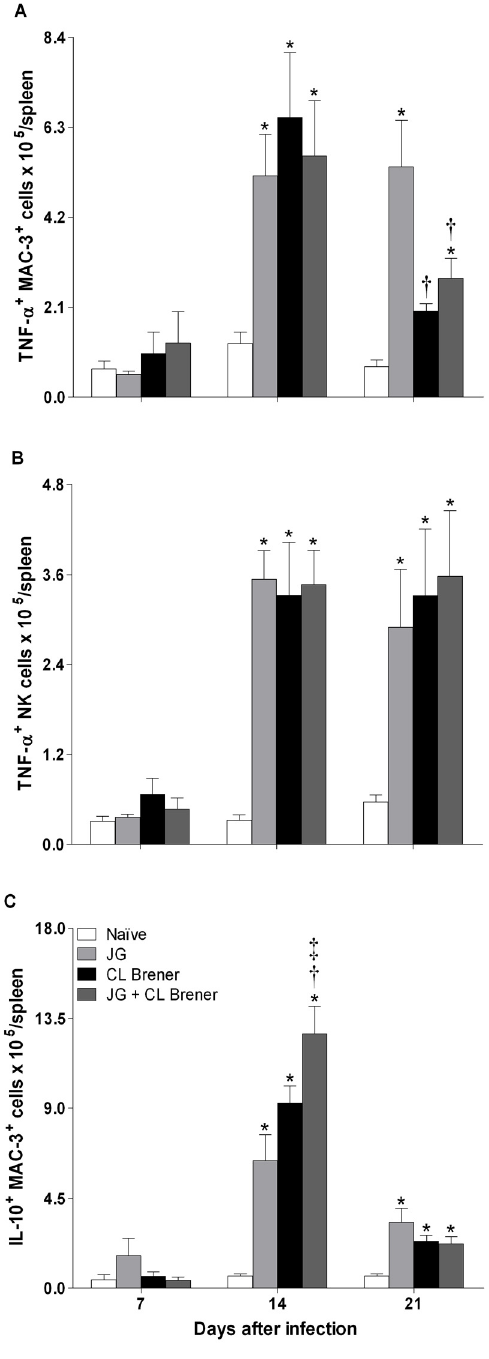
Figure 7. Flow cytometry analysis of splenic MAC-3 + and NK cells from BALB/c mice infected with JG and/or CL Brener. Groups of mice were infected with 100 trypomastigotes of JG or CL Brener (single infection) or coinfected with 100 trypomastigotes of both T. cruzi populations in a 1:1 ratio via the intraperitoneal route, and flow cytometry analysis of splenic MAC-3 + and NK cells was performed at 7, 14 and 21 days p.i. Symbols as follows: (A) TNF- a + /MAC-3 + ; (B) TNF- a + /NK; (C) IL-10 + /MAC-3 + ; white bar: Naı¨ve mice; light gray bar: JG infected mice; black bar: CL Brener infected mice; and dark gray bar: JG and CL Brener infected mice. Values are expressed as the mean 6 SEM of three mice per group (representative of two independent experiments). *, { and { represent P , 0.05 when compared with naı¨ve, JG and CL Brener mouse groups, respectively.